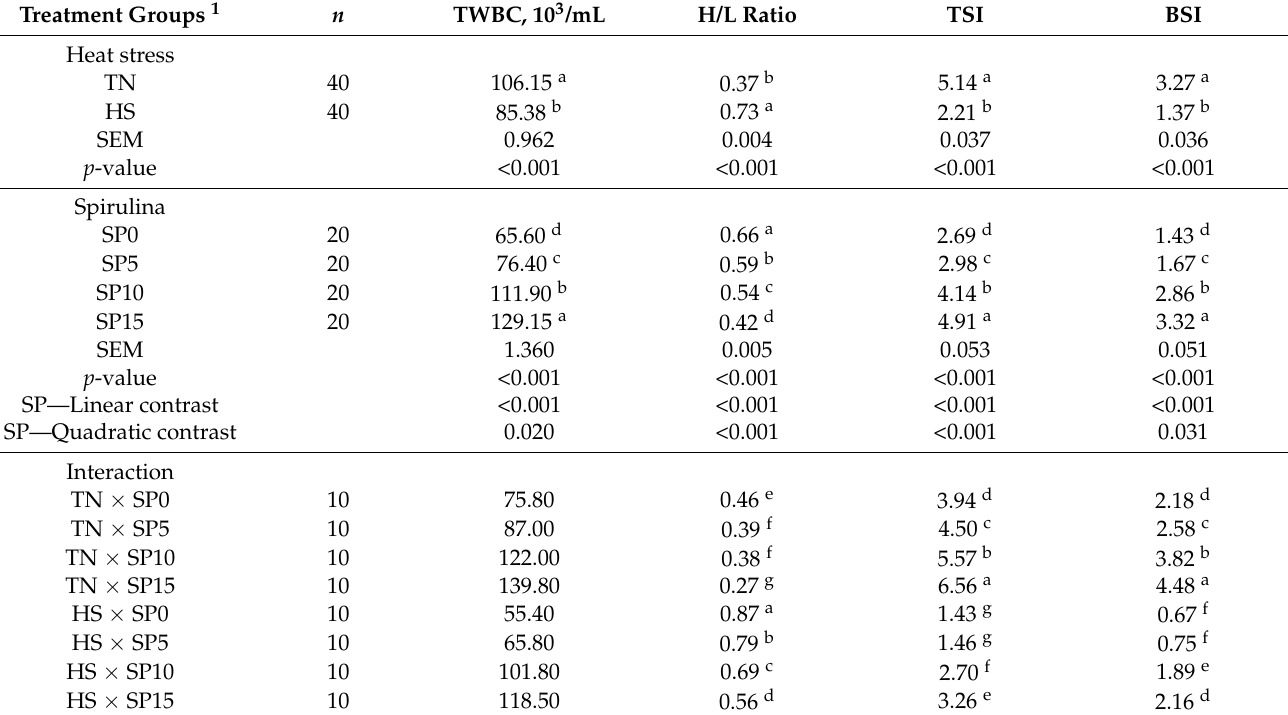
Table 7. Heat stress, spirulina, and their interaction effects on the immunological parameters of Japanese quail